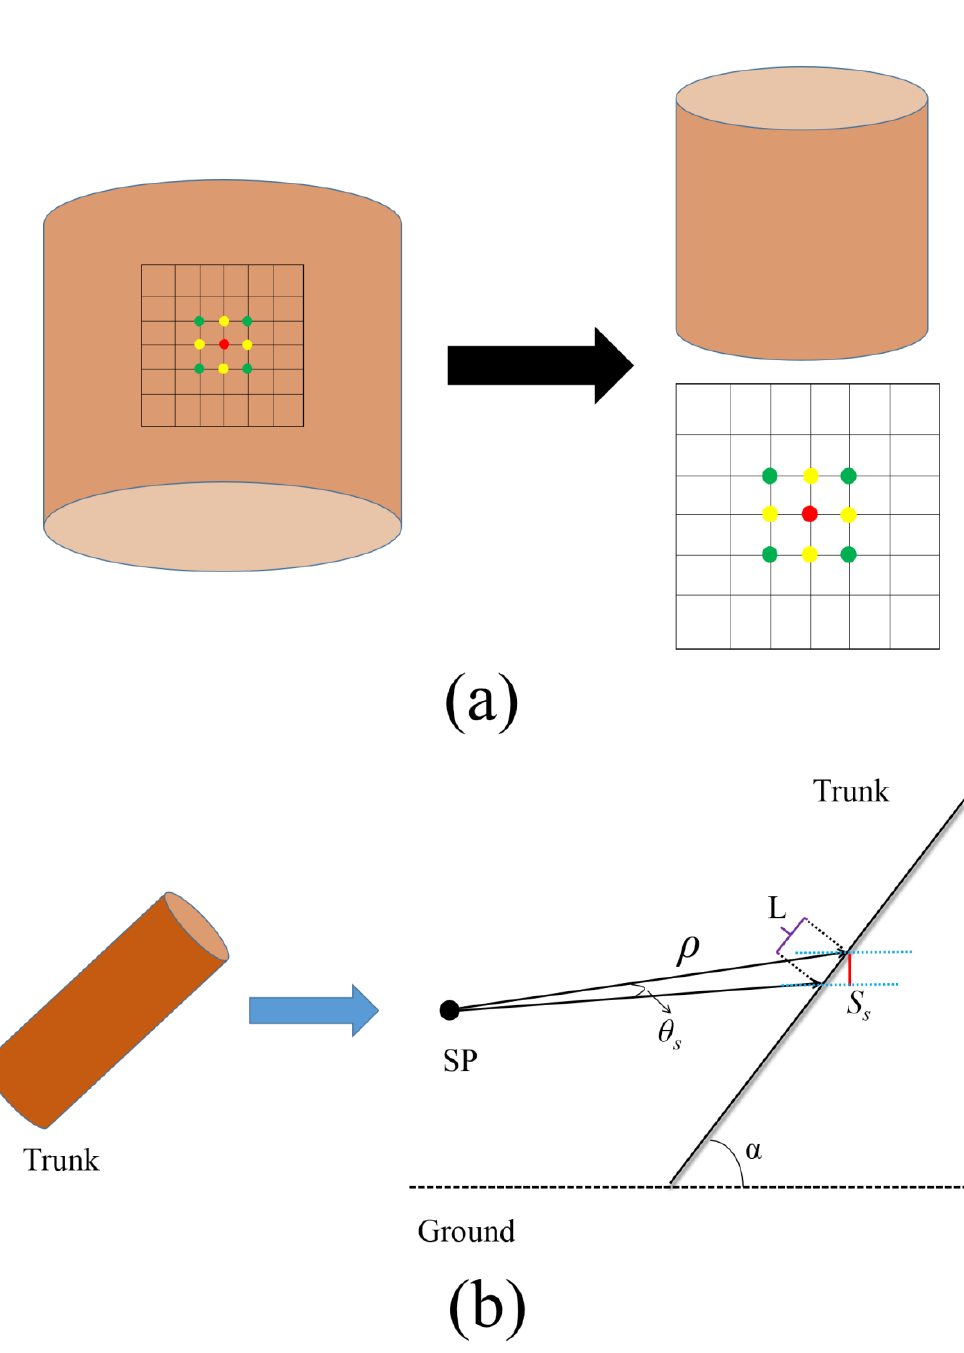
Figure 8. The demonstration of the eight nearest neighbors in the neighborhood classification. ( a ) Red point: target point; yellow point: the point where the d n value is S s ; green point: the point where the d n value is . ( b ) The black represents the position of point SP represents the position of scanner.